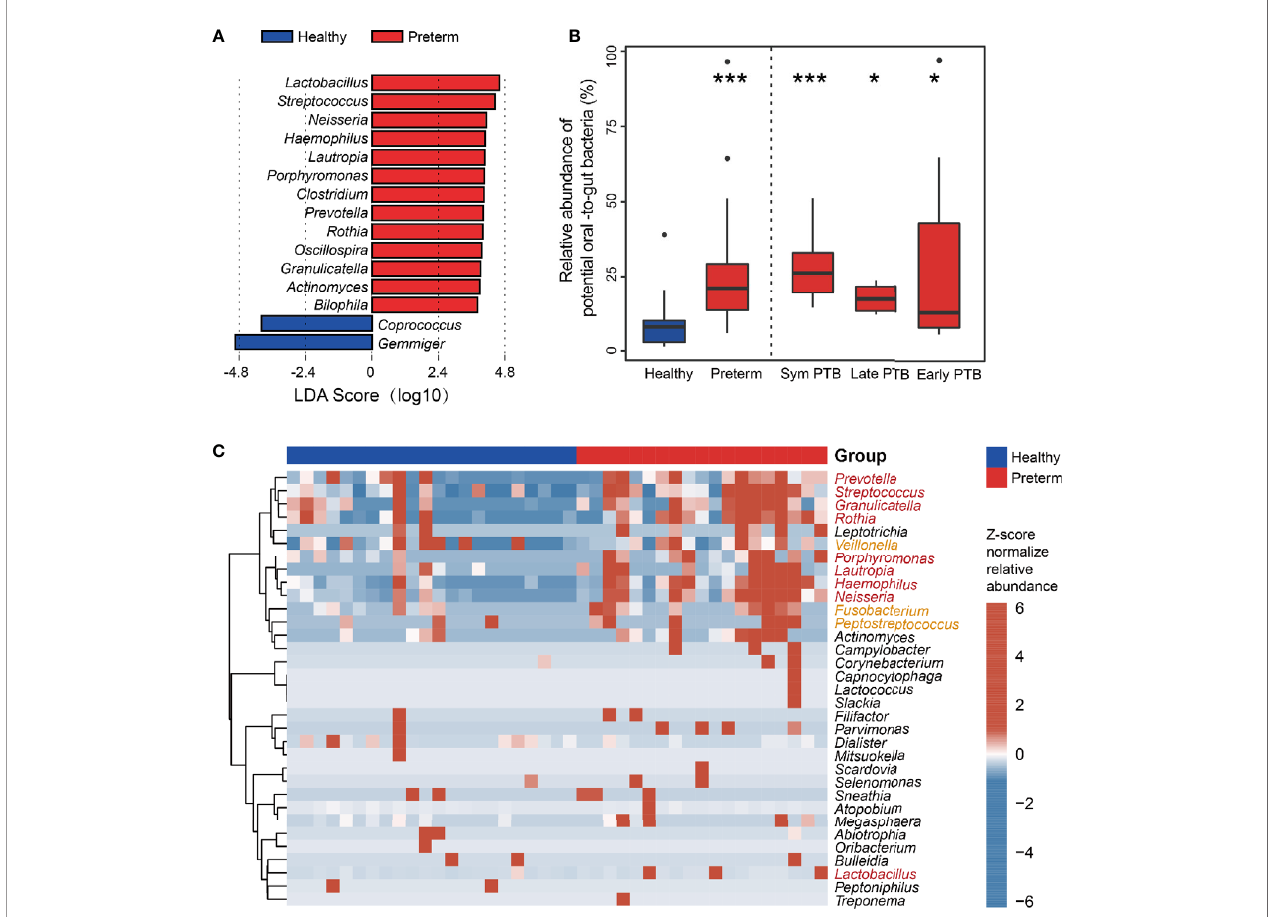
FIGURE 3 | Identi fi cation of the gut microbial biomarkers between the healthy and preterm groups. (A) LEfSe analyses of healthy and preterm groups. Linear discriminant analysis effect size identi fi ed the genus between the healthy and preterm groups. Preterm-enriched taxa are indicated with a positive LDA score, and taxa enriched in healthy controls have a negative score. Only taxa meeting an LDA signi fi cant threshold of >3 are shown. (B) Total relative abundance of the common oral bacteria. The relative abundance of the common oral bacteria in the healthy group, the preterm group, and the preterm birth subgroups (healthy group and preterm group are compared using Wilcoxon rank-sum test; subgroups are compared with healthy group using Wilcoxon rank-sum test and adjusted by the Benjamini and Hochberg method). (C) Genus comparison between healthy and preterm group. Bacteria identi fi ed by the Wilcoxon rank-sum test with p < 0.05 are shown in the heatmap. The bar on the top indicates the group information of each sample. Red genus represents the common oral bacteria that overlapped with LEfSe results. Yellow genera represent the common oral bacteria but not overlapped with LEfSe results. *p < 0.05; ***p <